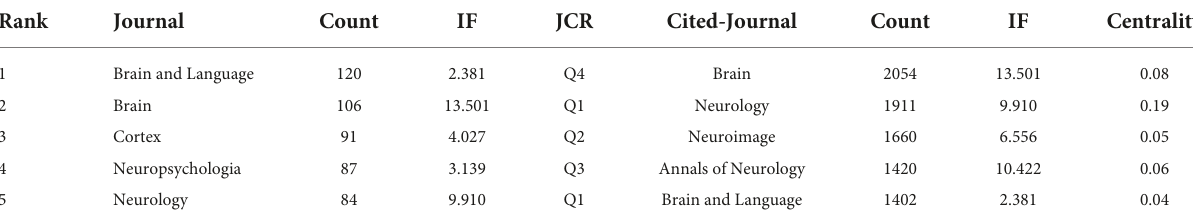
TABLE 2 Top 5 journals and cited-journals of neuroimaging research on aphasia.